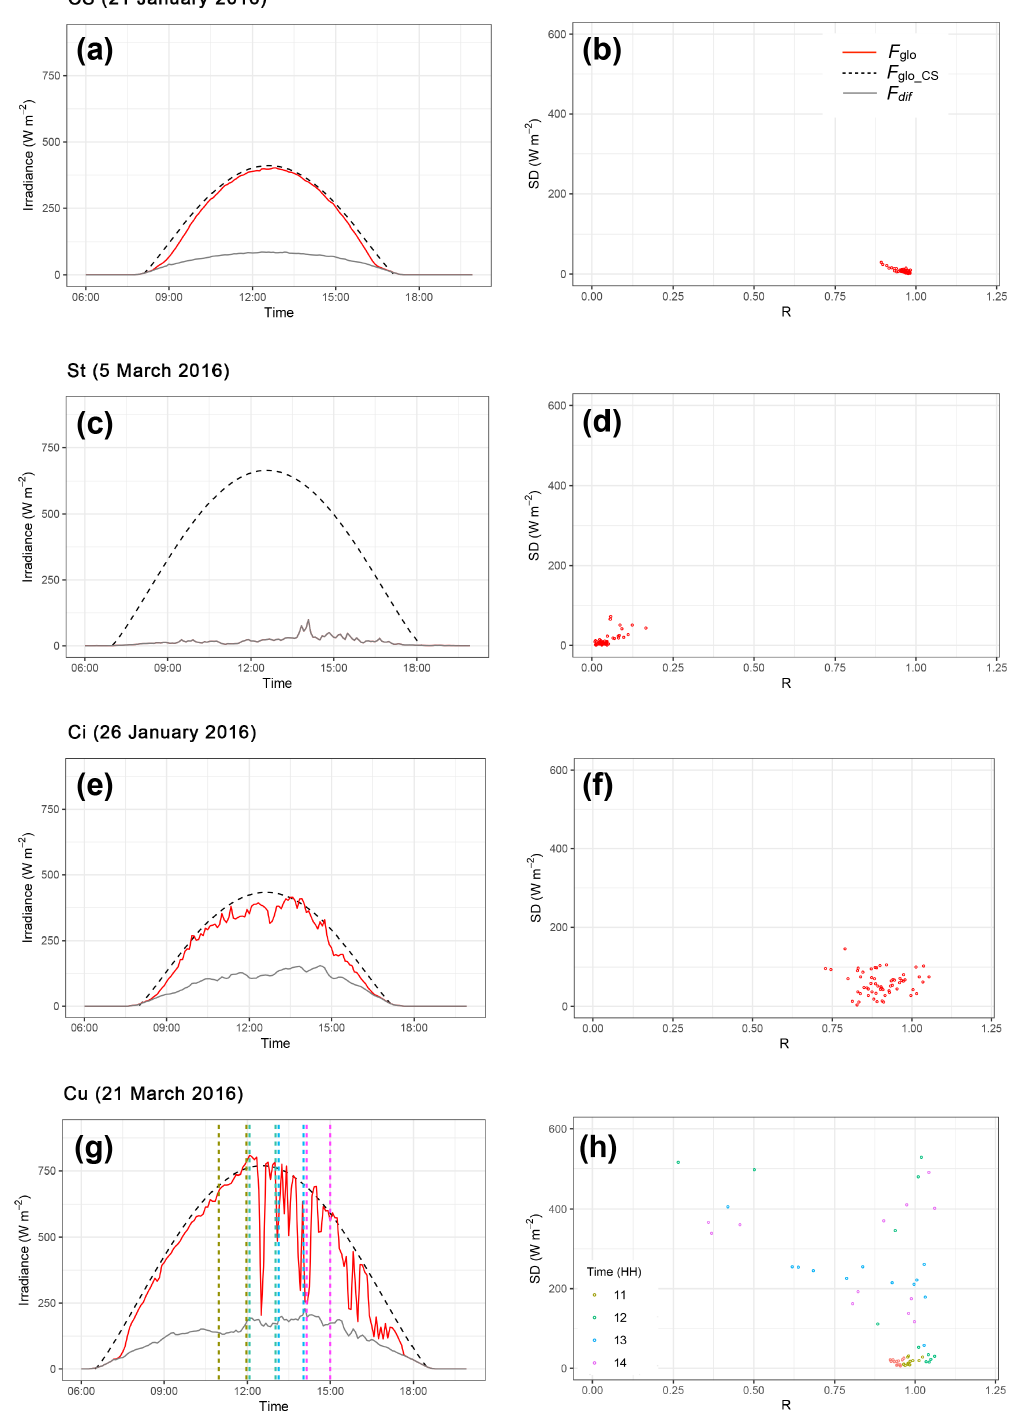
Figure 2. Cloud classification based on broadband solar radiation following Duchon and O’Malley (1999). Each row represents a different cloud type on a specific day as a case study. The left column represents the time series of global and diffuse measured solar irradiance ( F glo and F dif ) and modelled clear-sky irradiance ( F glo_CS ), while the right column contains the scatter SD– R plot of the observed SD of irradiance (SD) vs. the fraction of modelled clear-sky irradiance (R). In panel (h) different colours are related to different times (hours) of the day as reported in the